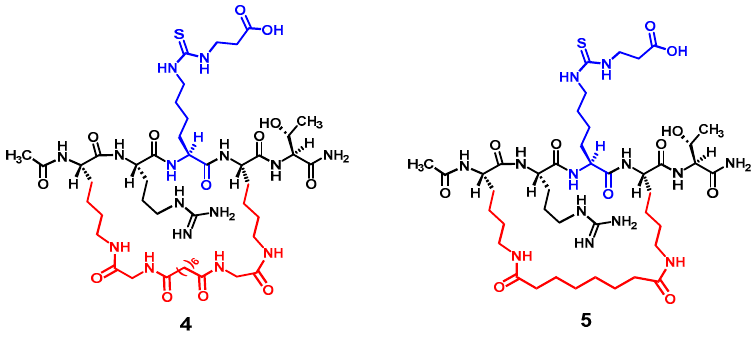
Figure 3. The chemical structures of the cyclic peptides 4 and 5 designed in the current study. Macrocyclic bridging units are shown in red, and the central warhead residue is shown in blue. Compounds 4 and 5 were prepared according to Schemes 1 and 2 by the Fmoc chemistry-based manual solid phase peptide synthesis (SPPS) on Rink Amide 4-methylbenzhydrylamine (MBHA) resin. The protecting groups Mtt and ivDde on lysine side chains were orthogonally deprotected respectively with 1% ( v / v ) trifluoroacetic acid (TFA)/ N , N -dimethylformamide (DMF) and 2% ( v / v ) hydrazine/DMF, as shown. Following the on-resin peptide macrocyclization and formation of the central N ε -ethoxycarbonylethyl-thiocarbamoyl-lysine residue, a cyclic peptide was cleaved from the resin with a TFA-containing cocktail (Reagent K). The obtained crude cyclic peptide was then purified by semi-preparative reversed-phase high performance liquid chromatography (RP-HPLC). The side chain ethyl ester on the central N ε -ethoxycarbonylethyl-thiocarbamoyl-lysine residue of thus obtained cyclic peptide was subsequently hydrolyzed in solution with LiOH, affording the crude 4 and 5 , which were again purified with semi-preparative RP-HPLC. The exact masses of the purified 4 and 5 were confirmed by high-resolution mass spectrometry (HRMS) analysis (Table 1).